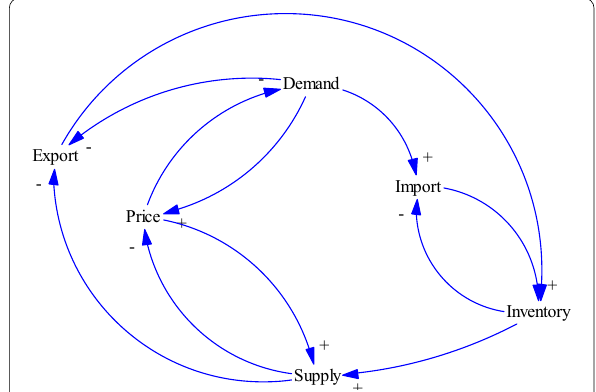
Fig. 4 Relationships between demand/supply and import/export